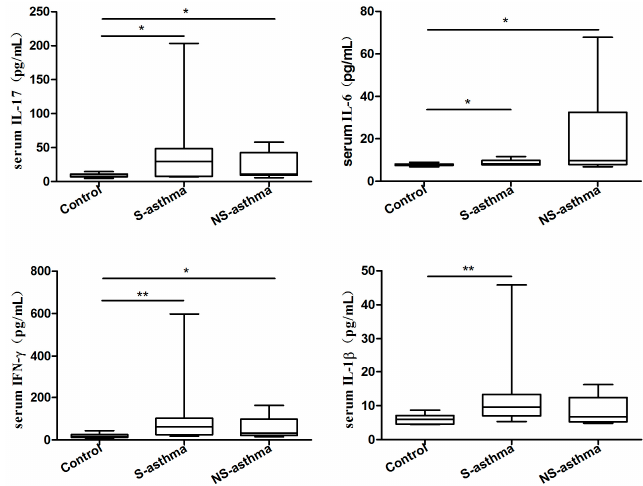
Figure 1. Comparison of serum concentrations of IL-38, periostin, IL-5, IL-13, IL-17, IL-6, IFN- γ and IL-1 β between asthmatic patients with or without steroid treatment, and control subjects. Serum IL-38, periostin, IL-5, IL-13, IL-17, IL-6, IFN- γ and IL-1 β were measured using ELISA and multiplex assay kit. Results are presented as box and whisker plots with median (interquartile range). Statistical significances were indicated by * p < 0.05 and ** p < 0.01 (Mann-Whitney U test). S-asthma: steroid-treated asthmatic patients, NS-asthma: non-steroid-treated asthmatic patients, control: control